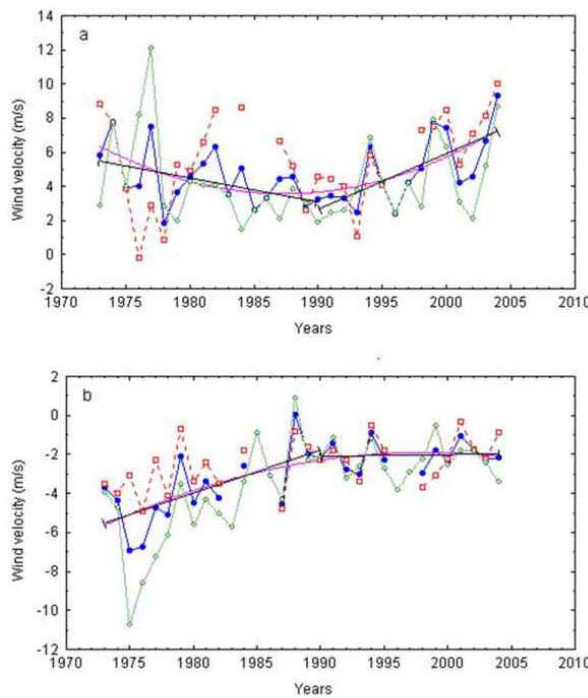
Fig. 4. MLT annual mean prevailing winds over Obninsk (55 ◦ N, 37 ◦ E) and Collm (52 ◦ N, 15 ◦ E), red: Obninsk, green: Collm, blue: mean values; (a) zonal component, (b) meridional